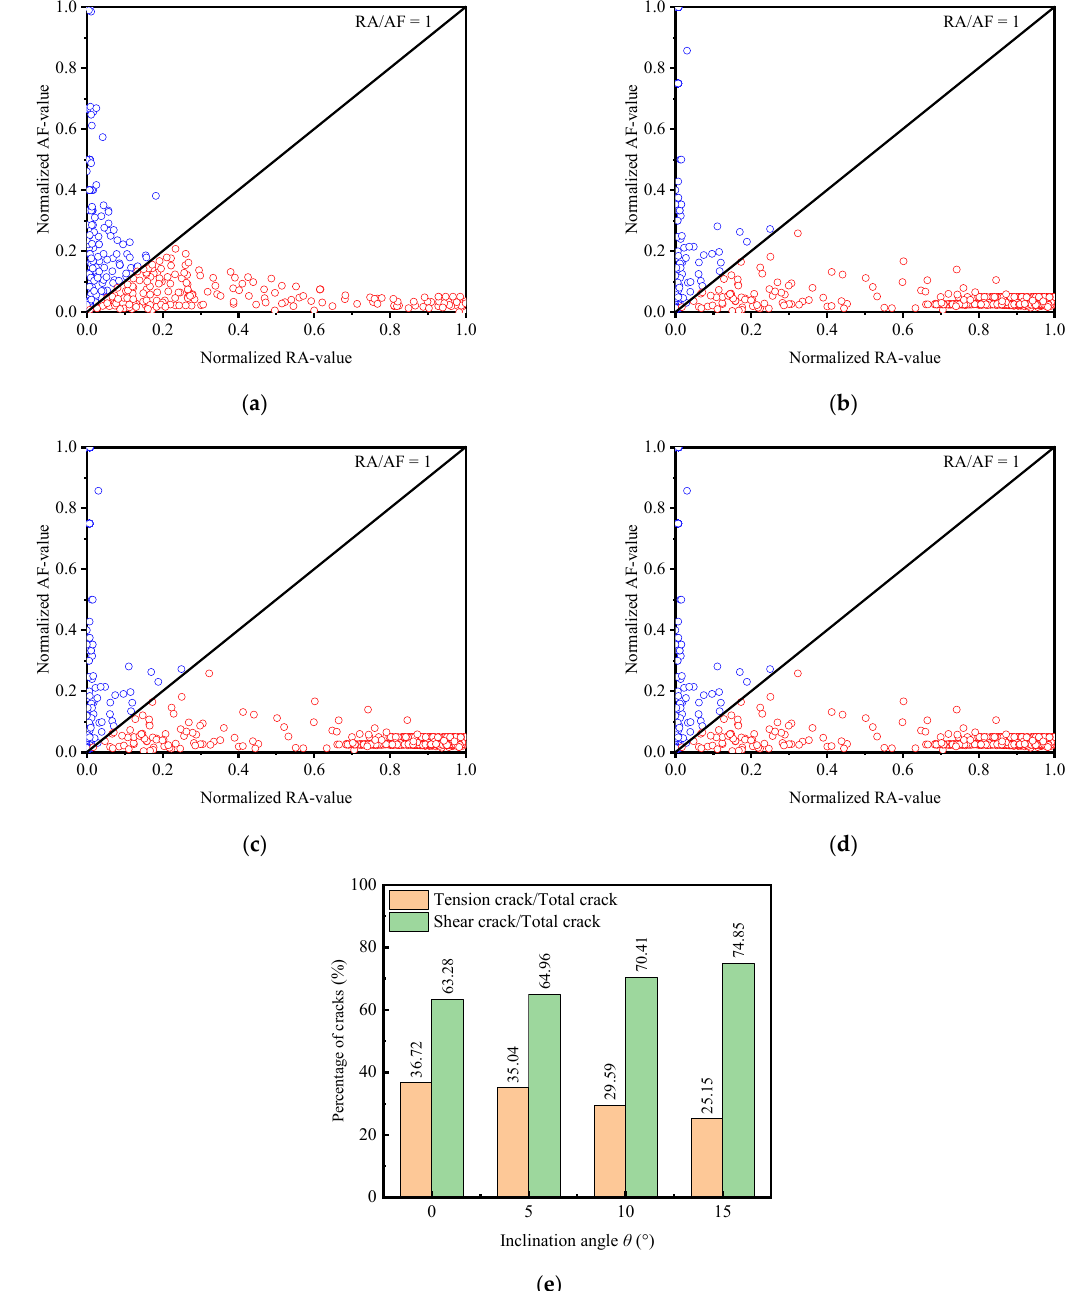
Figure 10. Tensile–shear crack evolution law of coal specimens under different inclination angles ( ω = 7.55%). ( a ) θ = 0 ◦ ; ( b ) θ = 5 ◦ ; ( c ) θ = 10 ◦ ; ( d ) θ = 15 ◦ ; ( e ) The proportion of tension–shear cracks in coal specimens under different inclination